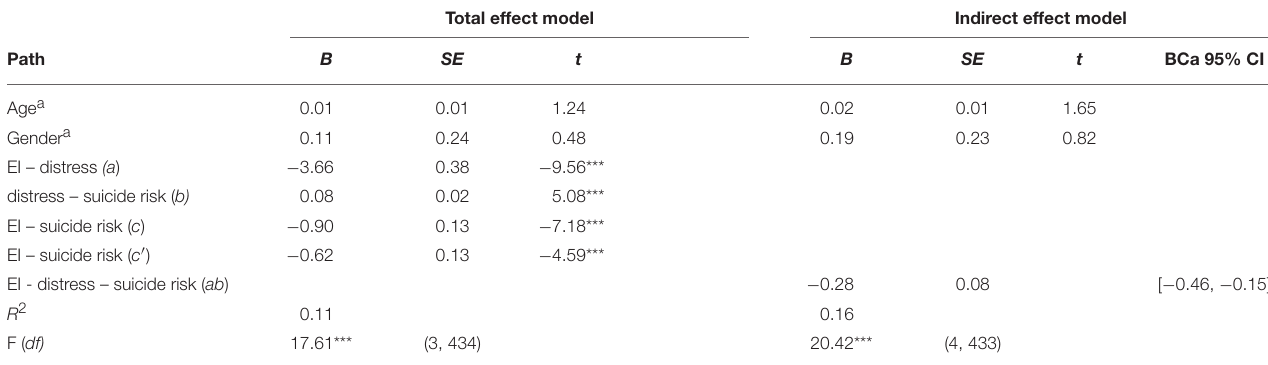
TABLE 2 | Indirect effects of Emotional Intelligence (EI) on suicide risk through psychological distress controlling for age and